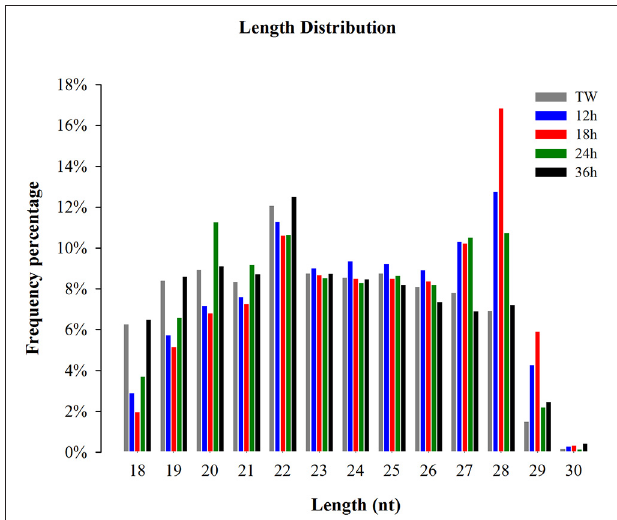
FIGURE 1 | Size distribution of small RNA reads in the libraries of Plutella xylostella . Different colors represent different libraries. X-axis represents small RNA length distribution and Y-axis represents frequency percentage. Tween (TW) was used as a